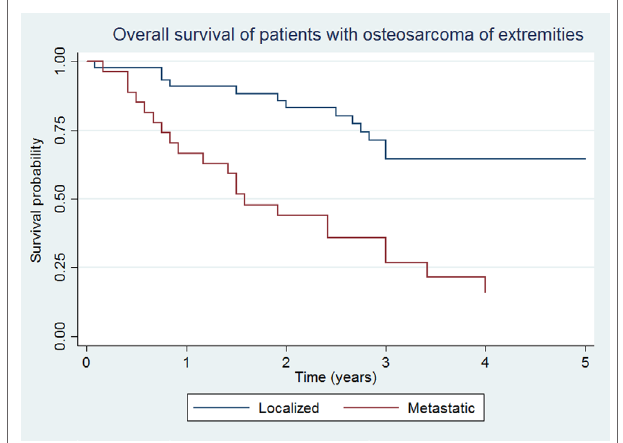
FigUre 1 | Overall survival of patients with localized and metastatic osteosarcoma of extremities ( N = 76)